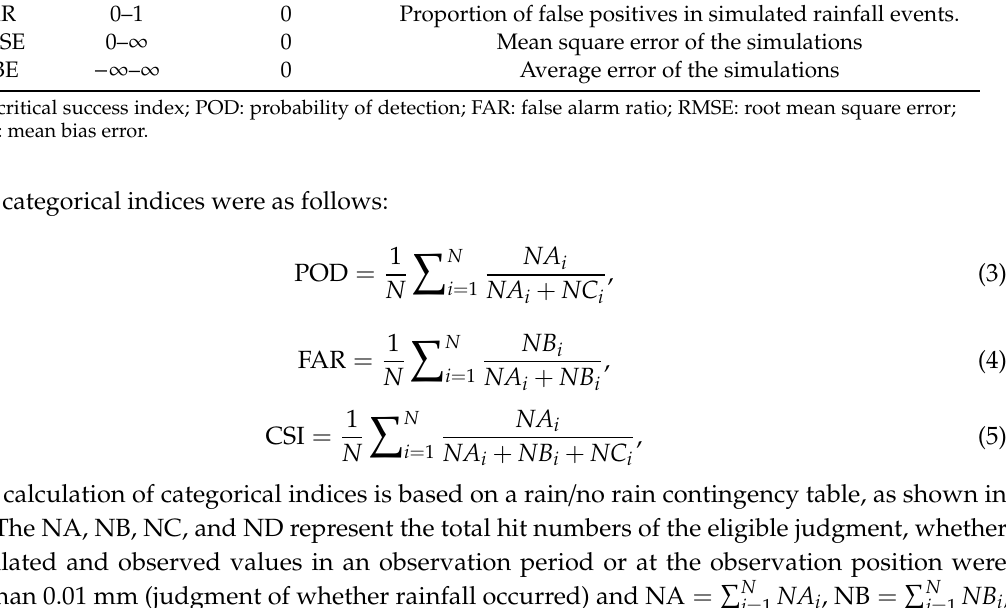
(cid:80) N (cid:80) N NA i , NB = NB i i = 1 i = 1